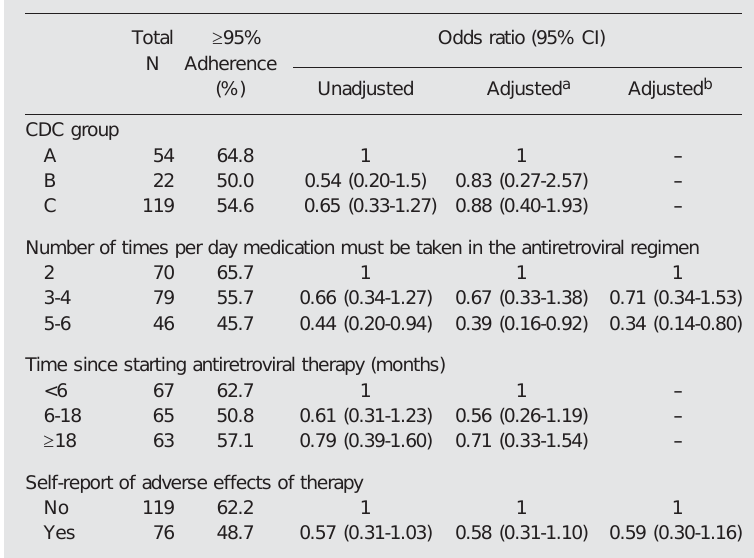
Table 3. Total number of patients in each group and percentages of adherent patients/ group ( (cid:2) 95% adherence).